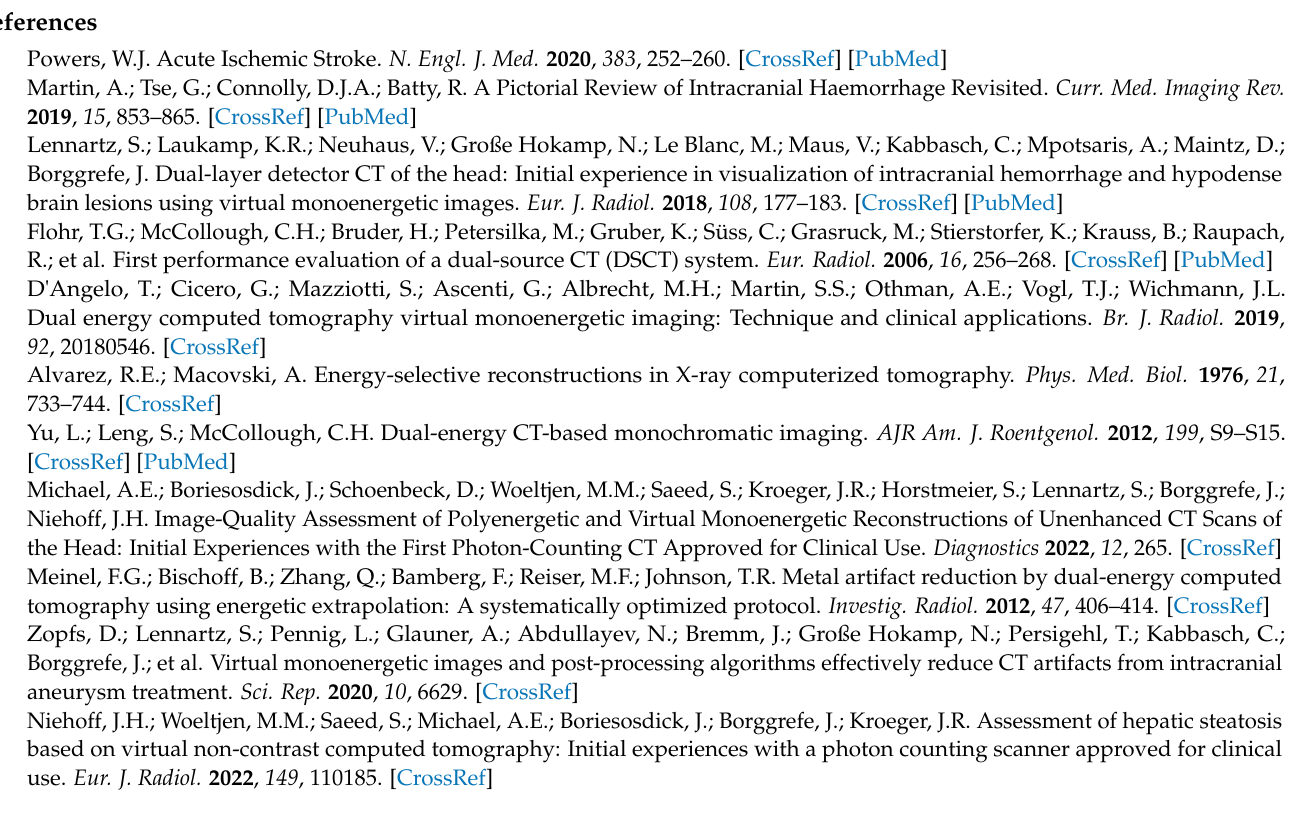
Table S3: CNR calculated with the noise of the muscle and the air, respectively. Comparison of Euler et al. (psoas muscle in CT angiography of the aorta) and current study (air or lateral pterygoid muscle in CT angiography of head and neck). Figure S2: Comparison of the CNR with different calculation: one time with the noise from the air, the other time with the noise from the